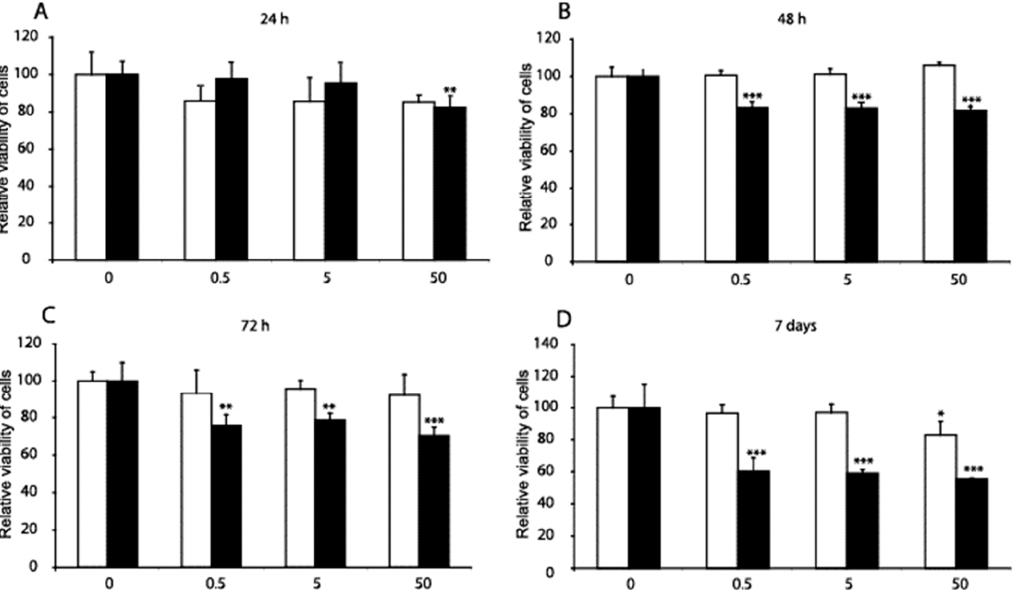
Figure 1. Comparison of the effects of diclofenac (DF) and methylprednisolone (MP) on the viability of MC3T3-E1 pre-osteoblast cells. The MC3T3-E1 cells were treated for 24 h, 48 h, 72 h, and 168 h ( A – D ) with three concentrations of DF (open bars) and MP (black bars): 0.5 µM, 5 µM, and 50 µM. The viability of the cells, determined by the 3-(4,5-dimethylthi- azol-2-yl)-2,5-diphenyltetrazolium bromide (MTT) assay, was expressed as the mean ± SD from four experiments and was compared to the untreated control. It was assumed that the viability of the control cells equals 100%. The significance was evaluated using one-way ANOVA with Tukey’s post hoc test. The significance level was set at 5% ( p < 0.05); significant at: * p < 0.05, ** p < 0.01, and *** p < 0.001.